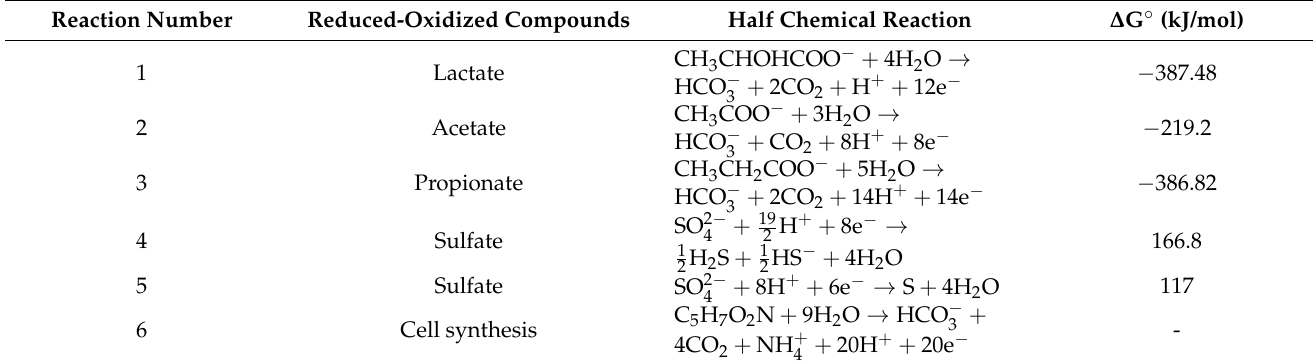
Table 2. Organic half-reactions and their Gibbs free energy for calculating electron balances between donor and acceptors used in this study